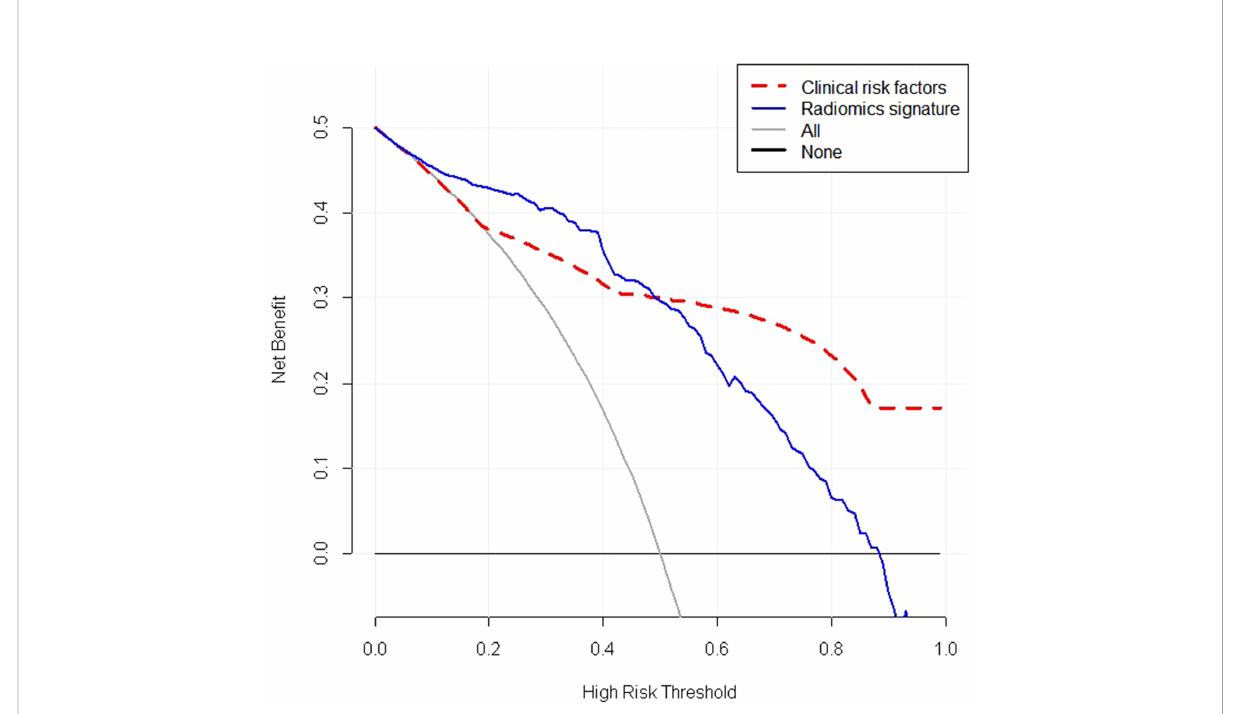
FIGURE 8 Decision curve analysis (DCA) of the radiomic signature(blue lines) and clinical risk factors(red lines). The y-axis represents the net bene fi t. The net bene fi t is determined by calculating the difference between the expected bene fi t and the expected harm related to each proposed model. The grey line represents the hypothesis that all lesions were malignant (the treat-all scheme). The black line represents the assumption that all lesions were benign (the treat-none scheme).As demonstrated in the curve, if the threshold probability was within a range from 0 to 0.9, the net bene fi t of using radiomics scores to predict malignancy added more bene fi t than either the treat-all scheme or the treatnone scheme. The net bene fi t of radiomics features were higher than that of clinical risk factors if the threshold probability was between 0 and 0.5. Radiomics signature: Radiomics